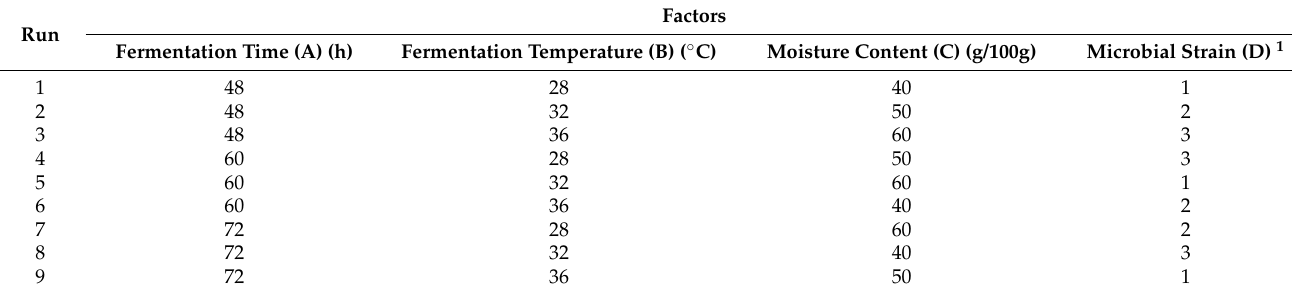
Table 2. Scheme of orthogonal L9 (3 4 ) design for optimum fermentation